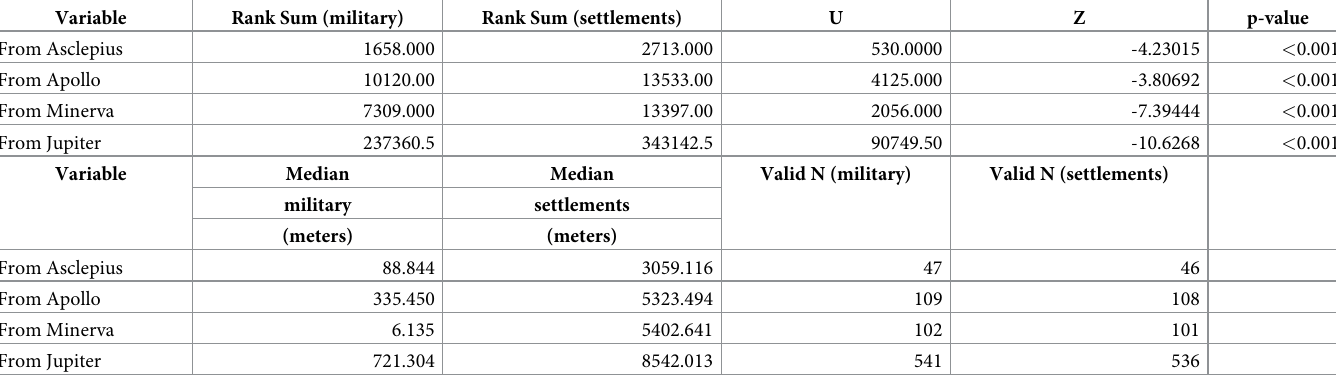
Table 2. Mann-Whitney U test results for distances from cult locations to their nearest military position and Roman settlements.